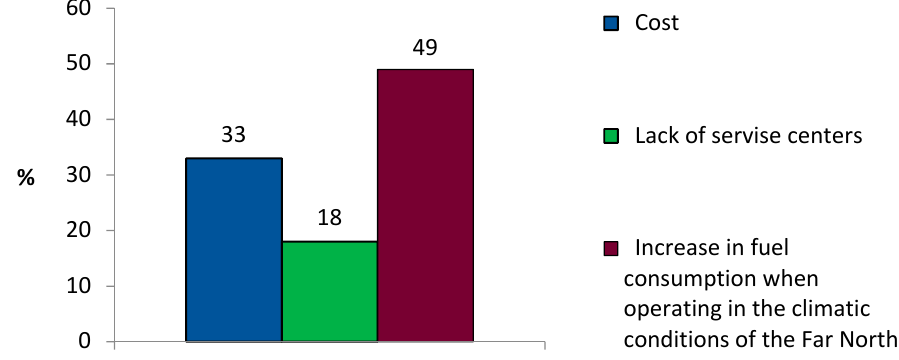
Figure 2. The results of a survey of drivers in the Republic of Sakha (Yakutia).